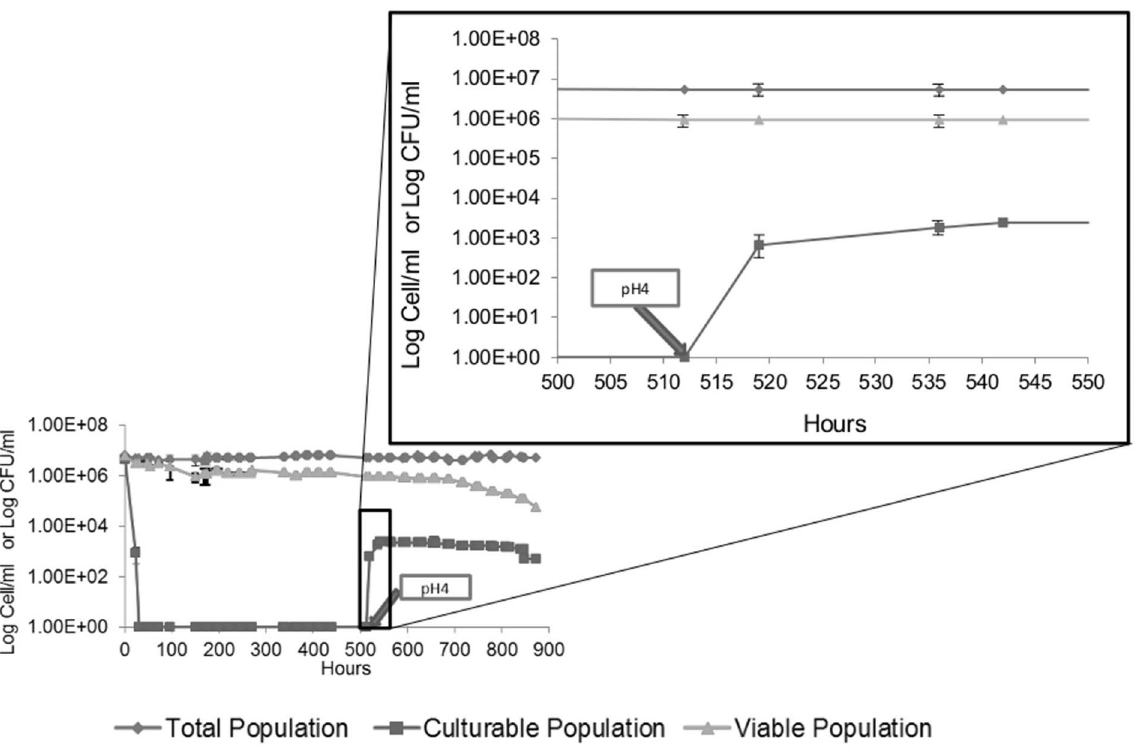
Figure 7. Exit rate of S.cerevisiae S288C from the VBNC. Total cell counts ( ¤ ), culturable counts ( & ), and viable counts ( m ) are shown. Resuscitation was induced by removal of the molecular SO 2 at 21 days after entry into VBNC state. Value 1 corresponds to an undetectable number (less to 10 CFU/mL). The values presented are the average of three replicates of three separate experiments.